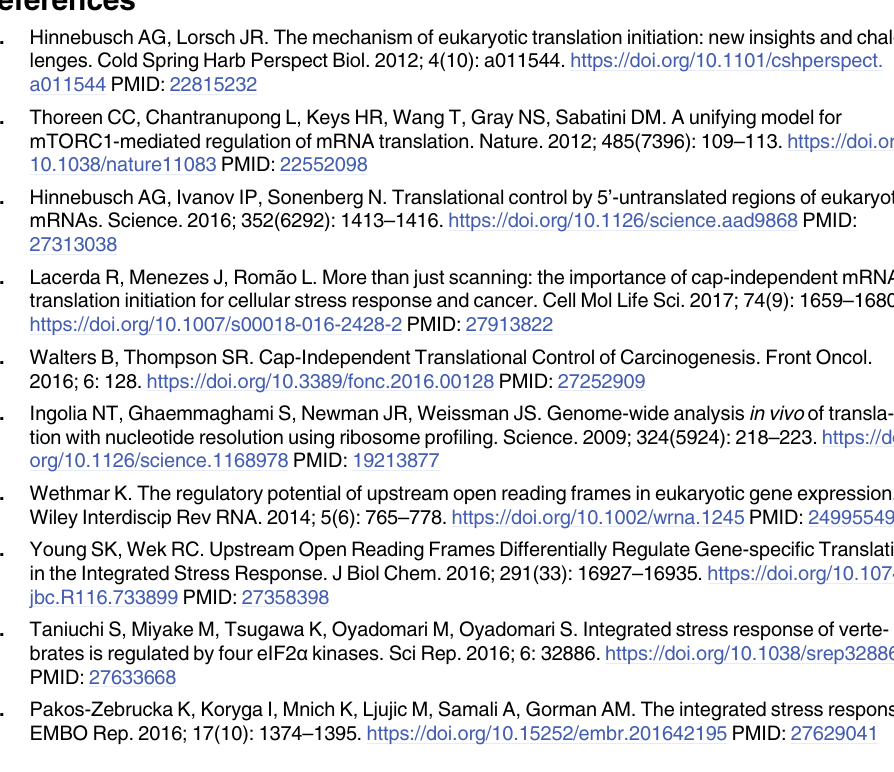
S2 Table. Lists of uORFs in the comprehensive and in the experiment-specific annotation files. S3 Table. Output files generated using the comprehensive or the experiment-specific anno- tation